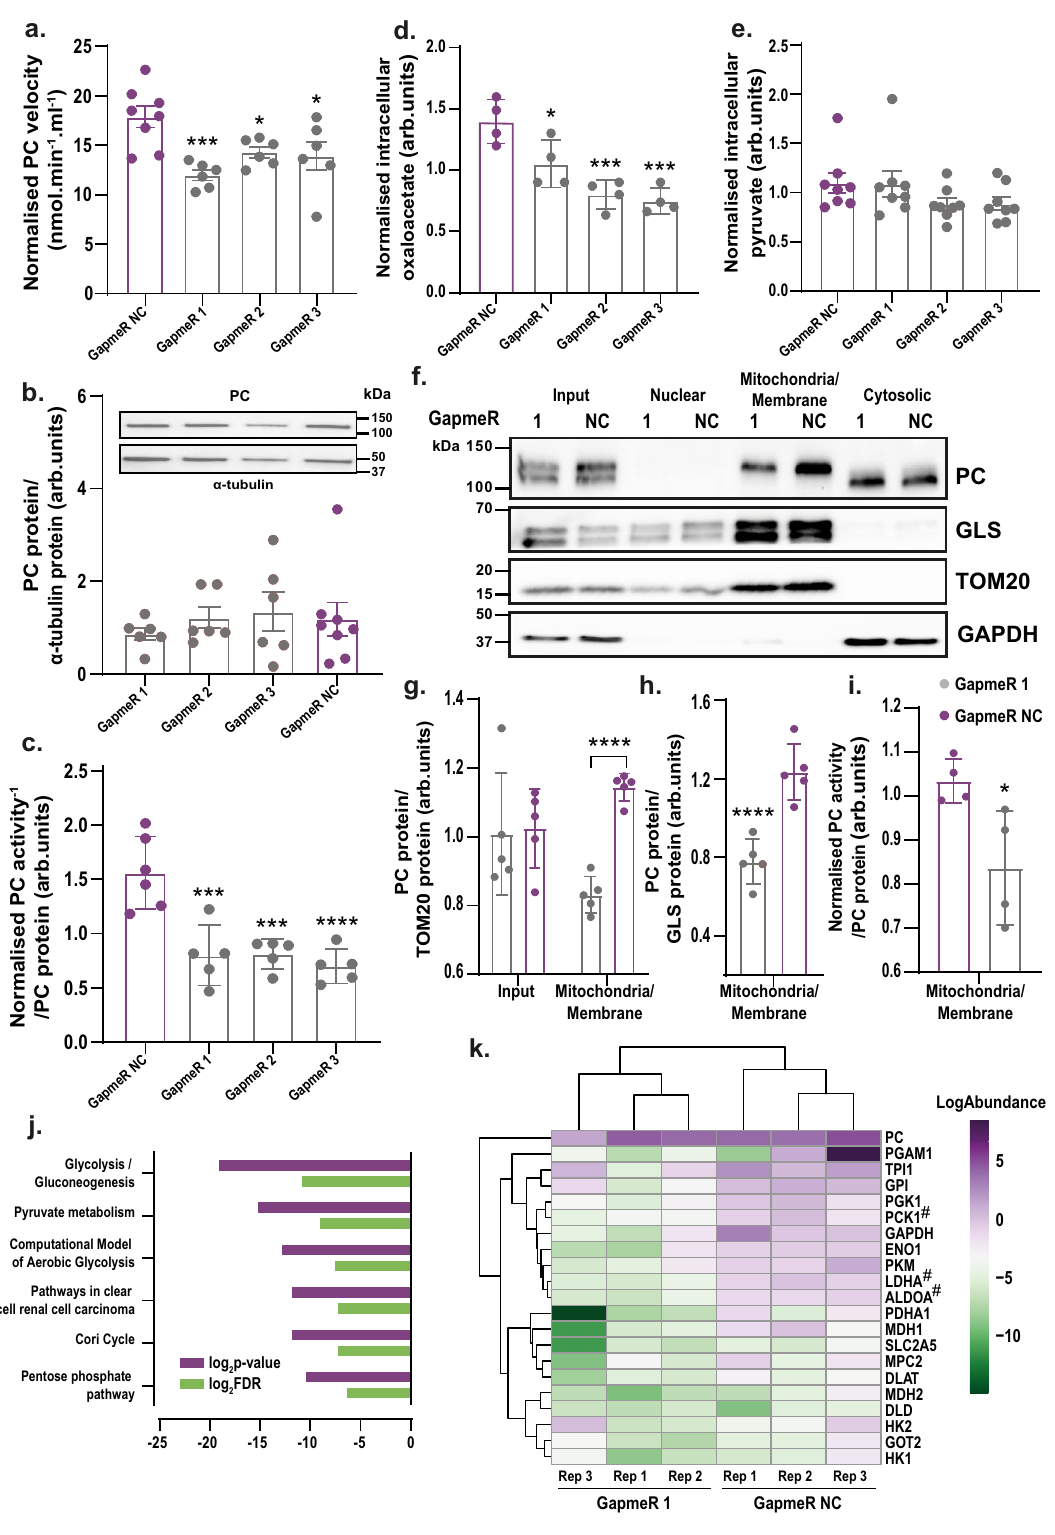
In short, ADIPINT is an adipocyte-speci fi c polynucleotide that regulates lipid metabolism in part by acting as a gatekeeper of PC function. The exact molecular mechanism leading ADIPINT to alter PC remains to be de fi ned. Further studies are needed to establish the physiological consequences of this RNA-protein interaction and determine its suitability as a therapeutic